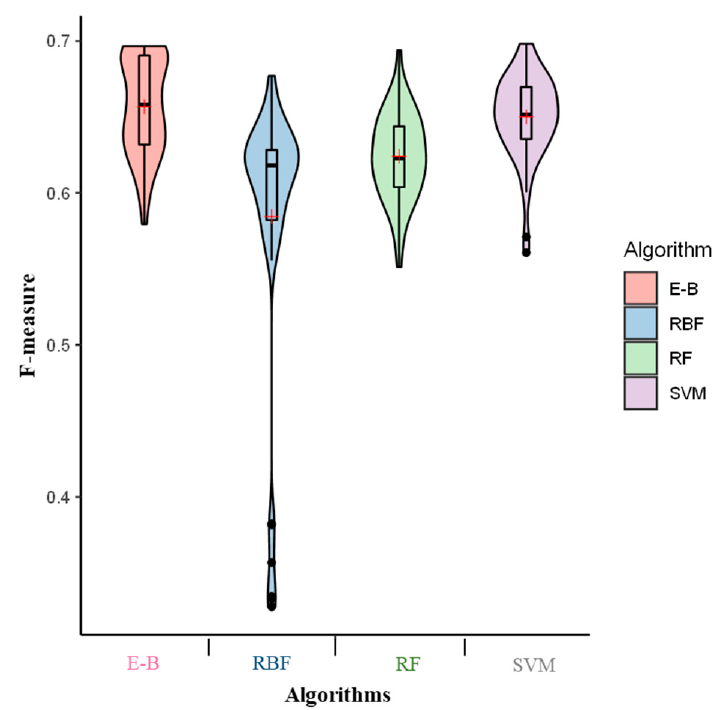
Figure 3. F-measure of the radial basis function (RBF), support vector machine (SVM), random forest (RF), and ensemble-bagging (E-B) algorithms for off-target activity prediction using MIT and CDF scores. × indicates the mean performance of F-measure.